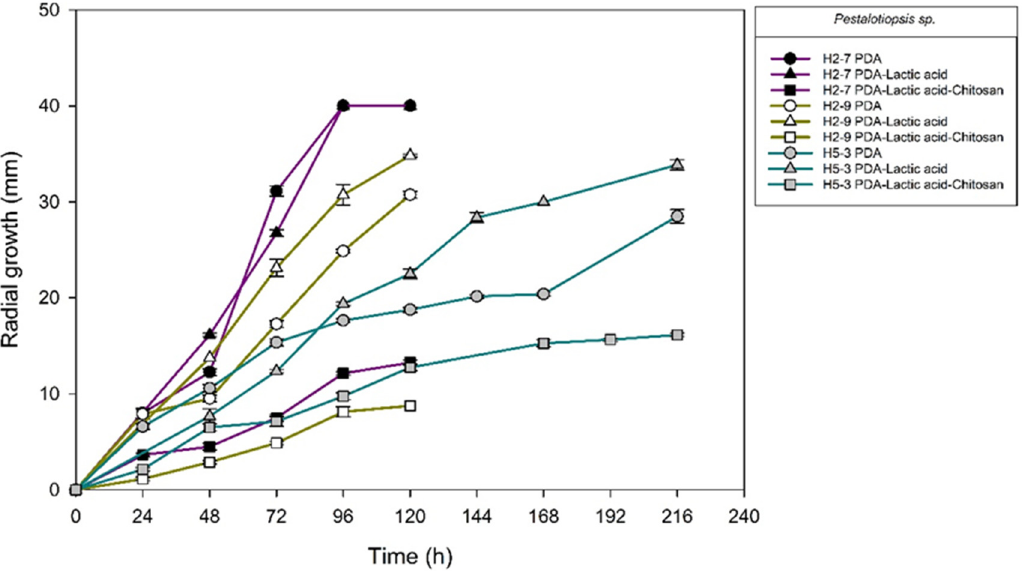
Figure 10. Pestalotiopsis sp. isolates from anthracnose of mango. Kinetics of radial growth (mm) in medium PDA, PDA-lactic acid (0.05 M), and PDA-lactic acid (0.05 M) with 1 g L- 1 chitosan at 25 °C.